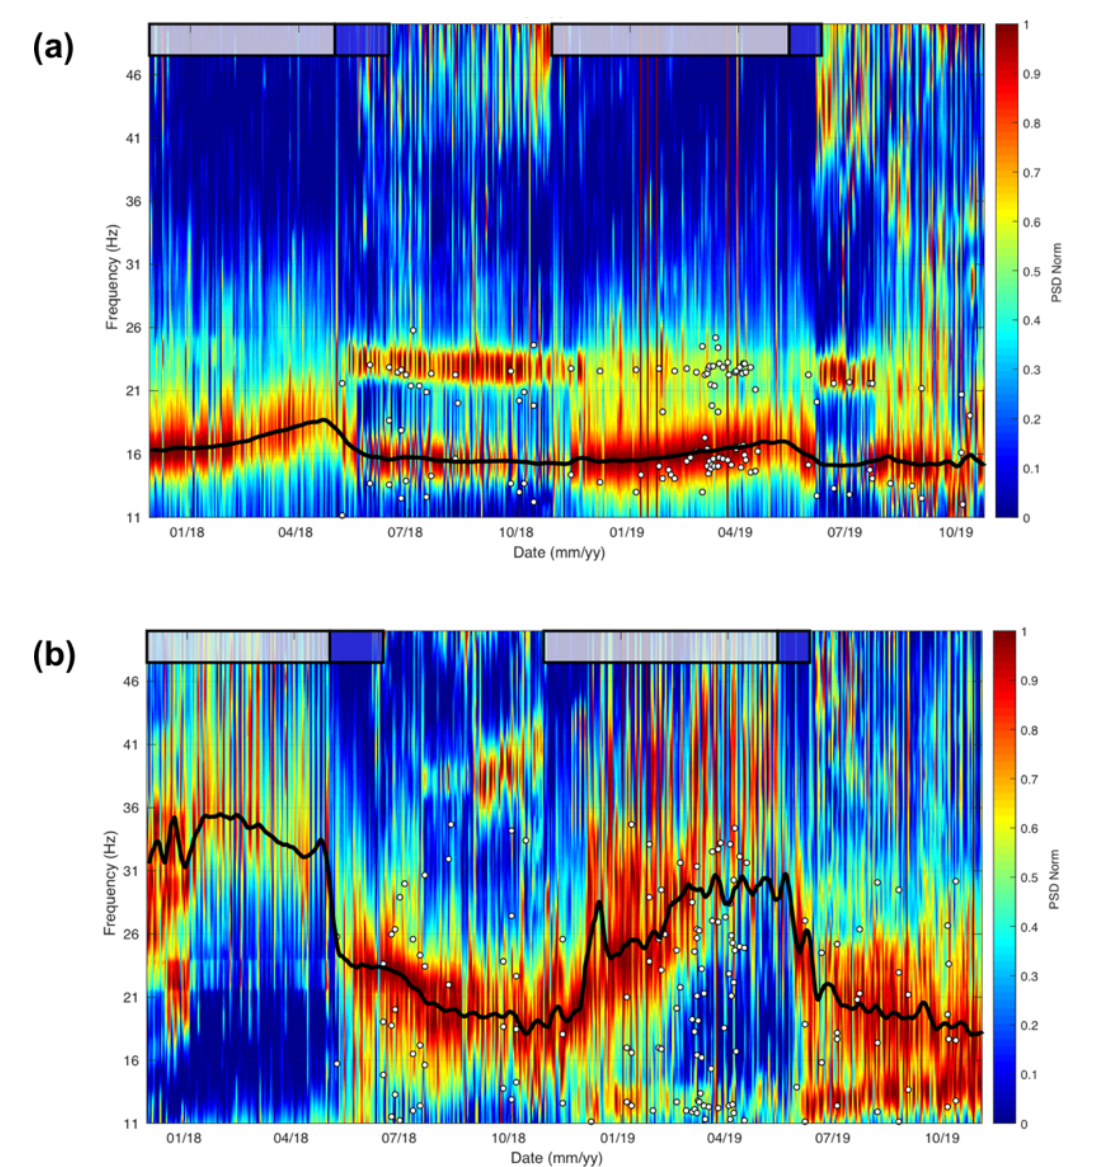
Figure B2. Normalized power spectral density (PSD) from hourly spectrograms of the passive seismic recordings of Laurichard site from (a) C00 seismometer and (b) C05 seismometer. The bold black line denotes the moving-window average of hourly spectrogram maxima. For each recorded earthquake ( M > 2), the local maxima have been automatically picked (white dots) if they appear significantly on the spectrogram. Snow cover and melting periods are depicted by white and blue boxes,